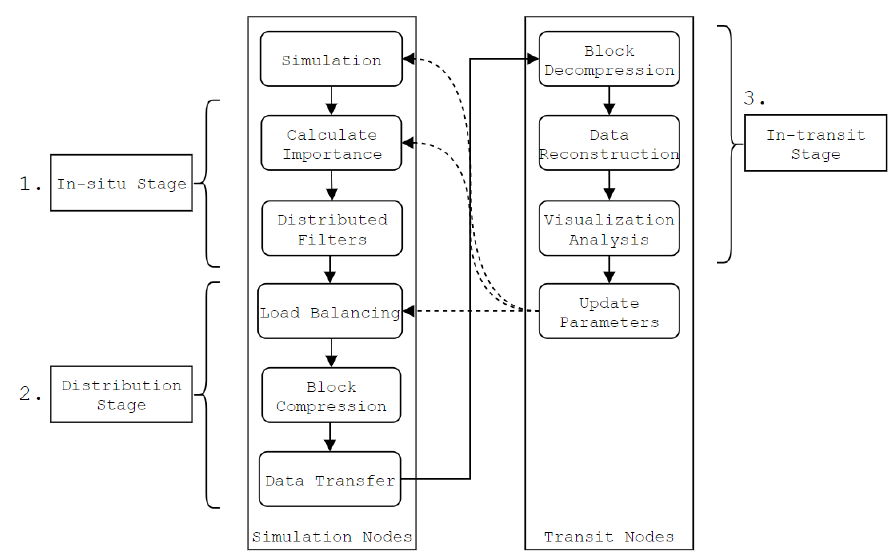
Figure 2. Typical in-transit workflow using the proposed approach. 3D data sets are partitioned into blocks, analyzed and compressed in parallel on the simulation nodes. The blocks are then transferred to the transit nodes, where they are decompressed and reconstructed into the original data